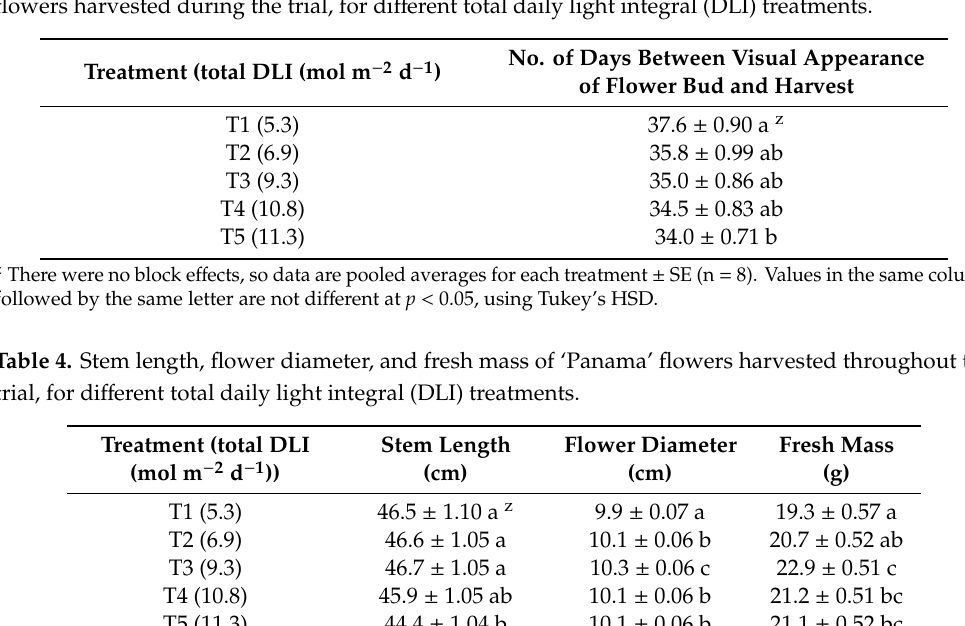
Table 3. Days between appearance of flower buds (i.e., stems ≥ 1 cm) and harvest for all ‘Ultima’ flowers harvested during the trial, for different total daily light integral (DLI) treatments.